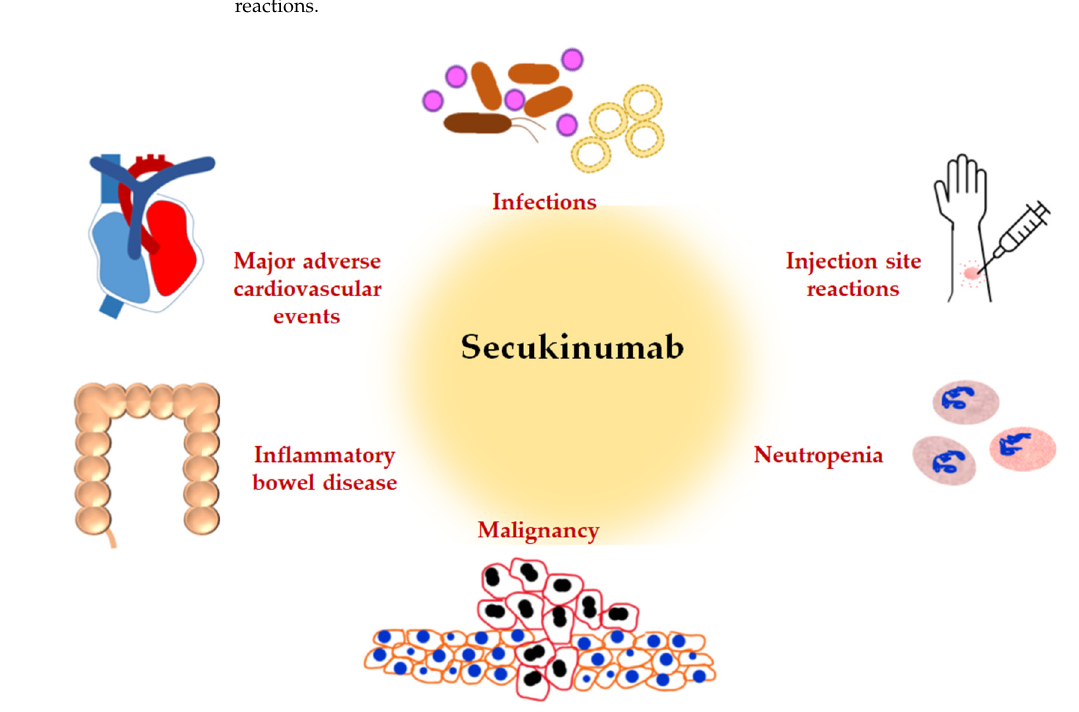
Figure 2. Potential adverse effects of secukinumab.